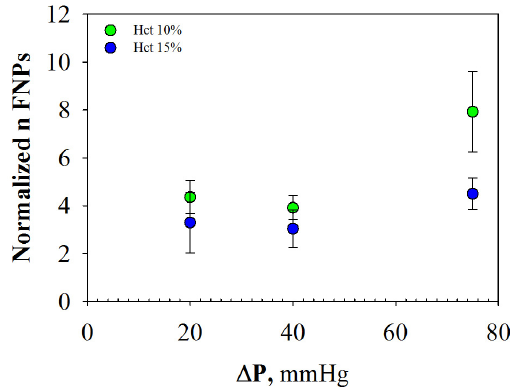
Figure 7 ． Normalized number of FNPs marginated as a function of shear rate at 10% and 15% Hct. There is a significant difference between the two sets of data at 75 mmHg ( p = 0.030). (For interpretation of the references to color in this figure legend, the reader is referred to the web version of this article).